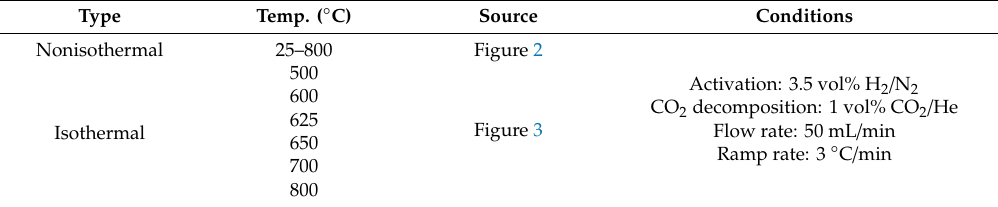
Figure 5. XRD powder patterns of SrFeO 3 − δ tested for CO 2 decomposition measurements: ( a ) After nonisothermal test, ( b ) after five cycles at 700 ◦ C, ( c ) in-situ XRD at 700 ◦ C, and ( d ) after six cycles at 650 ◦ C. The symbols indicate perovskite (p) and brownmillerite (b). Table 3. Experimental conditions of nonisothermal and isothermal tests with SrFeO 3 − δ